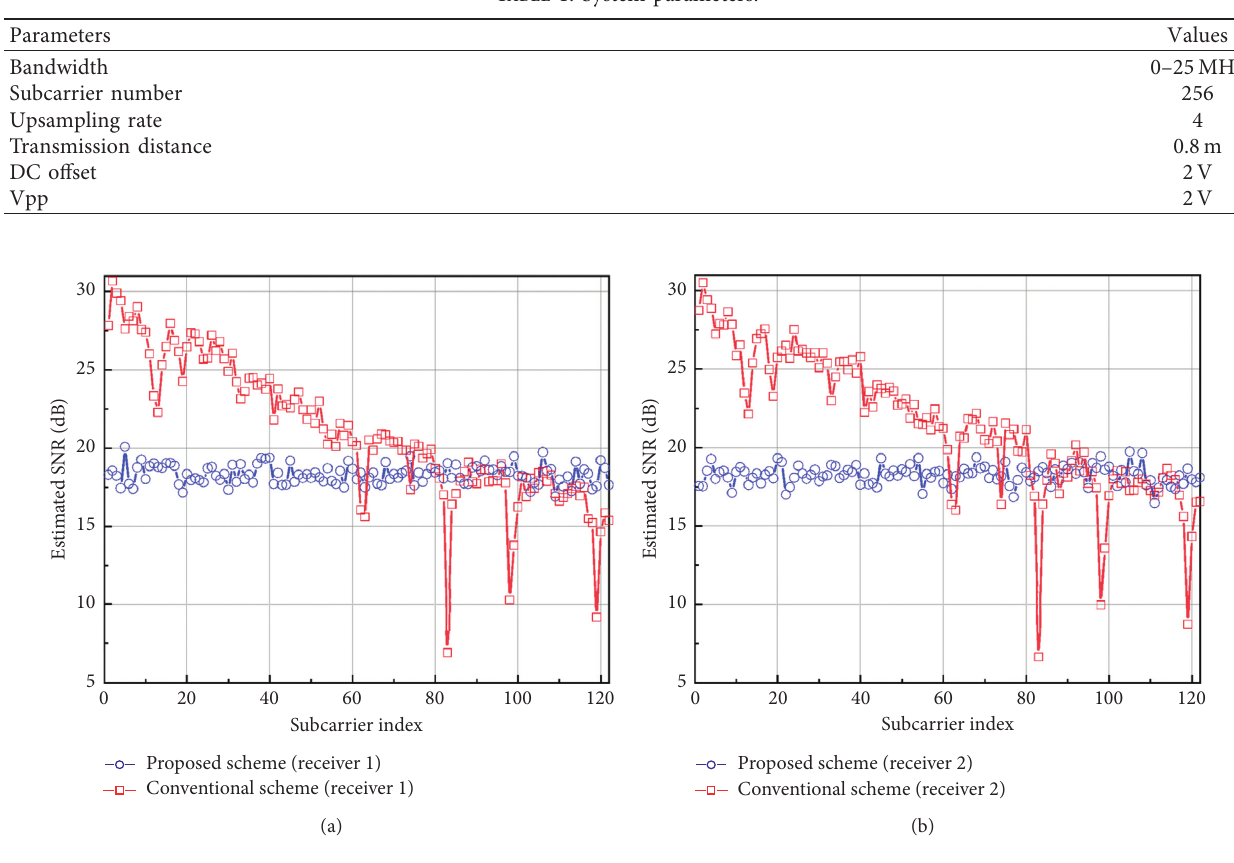
Figure 2: Estimated SNR as a function of subcarrier